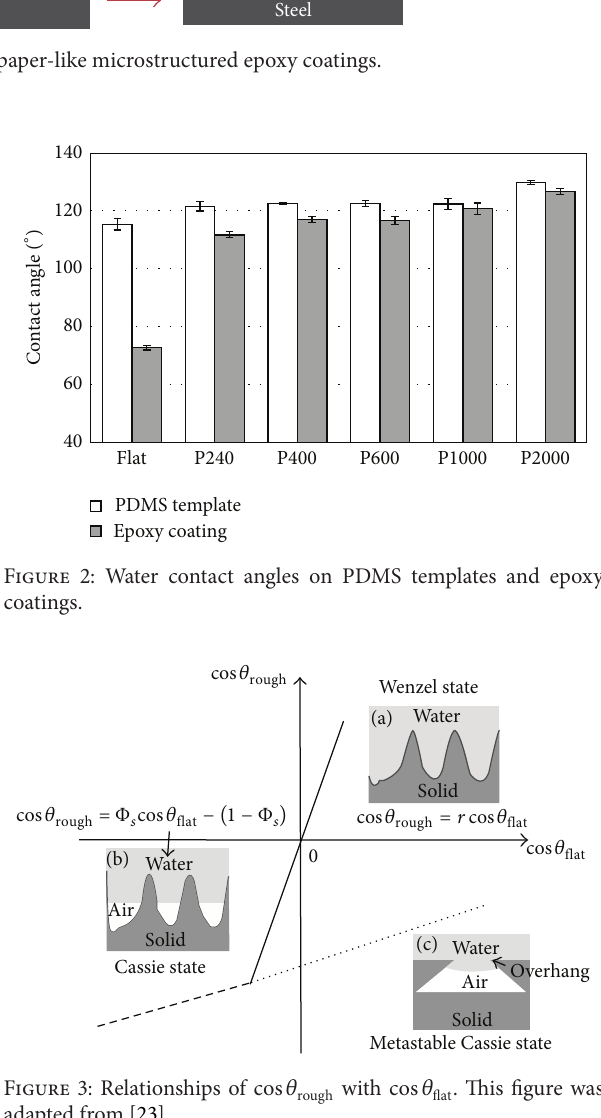
with cos 𝜃 . This figure was rough flat